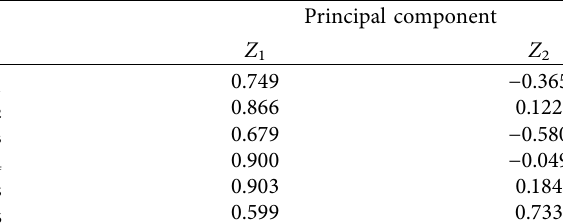
Table 5: The component score coefficient matrix.